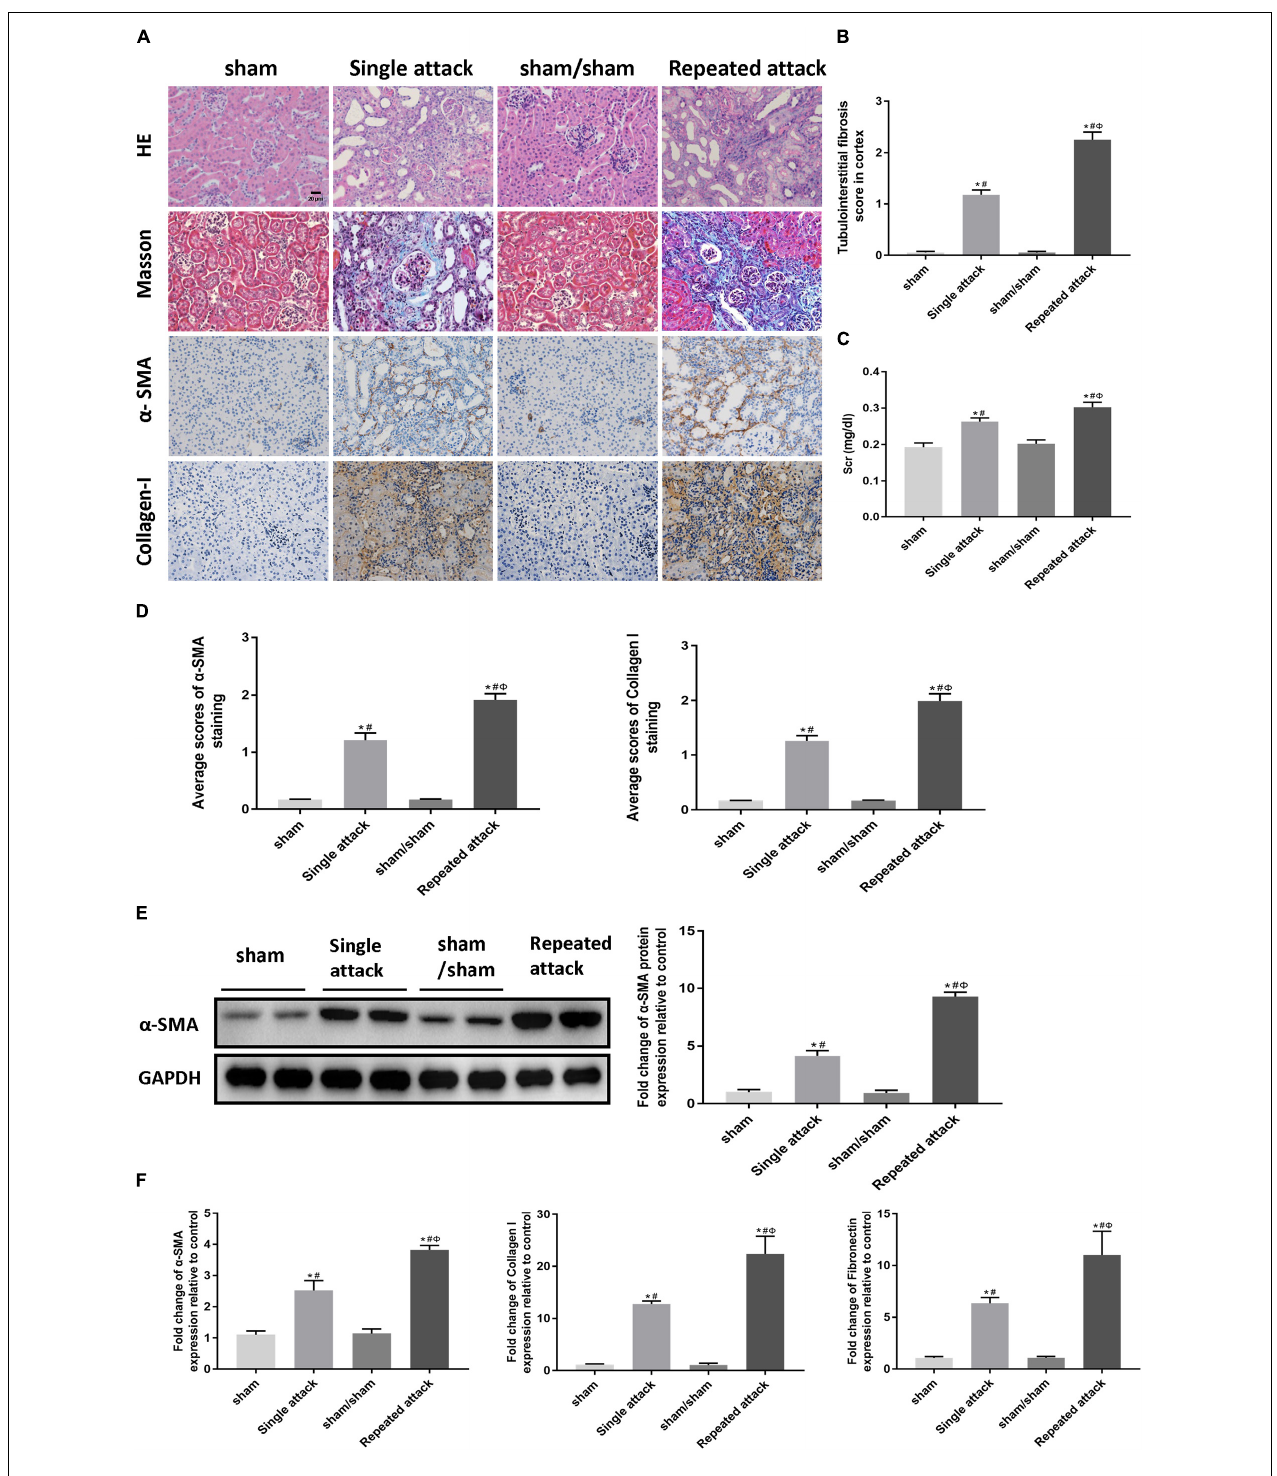
FIGURE 6 | Repeated episodes of moderate IRI accelerated kidney injury in mice. (A) HE and Masson’s trichrome staining as well as immunohistochemical staining of α -SMA and collagen I in kidneys at day 14 after the first renal ischemia attack are shown (original magnification × 400; Scale bar, 20 µ m). (B) Tubulointerstitial fibrosis score of mouse kidneys at day 14 after the first renal ischemia attack. (C) Changes in Scr levels in mice at day 14. (D) Semiquantitative data of α -SMA and collagen I staining in different groups of mice. (E) Western blot analysis of α -SMA in the kidney tissue lysates of mice in each group. The densitometry analyses of Western blot are shown. (F) Effect of the frequency of ischemia attack on the mRNA expression of fibrosis markers in kidney tissue lysates. Data are presented as the means ± SEM of four experiments. n = 6; ∗ P < 0.05 vs. the sham control group. # P < 0.05 vs. the sham/sham group. (cid:56) P < 0.05 vs. the single-attack group.